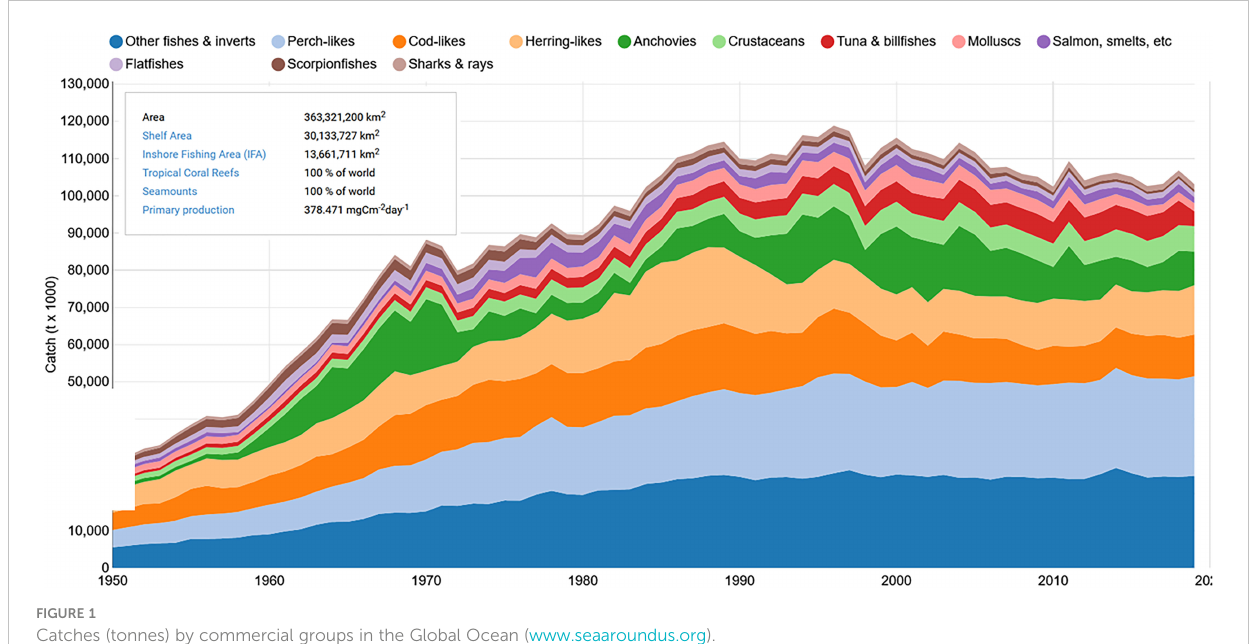
FIGURE 1 Catches (tonnes) by commercial groups in the Global Ocean